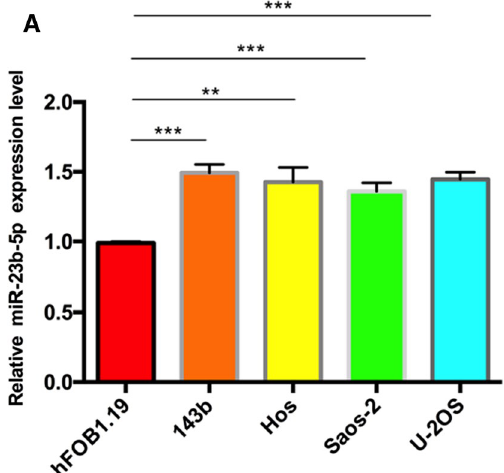
shown as mean ± SD from three independent experi- ments. **P <